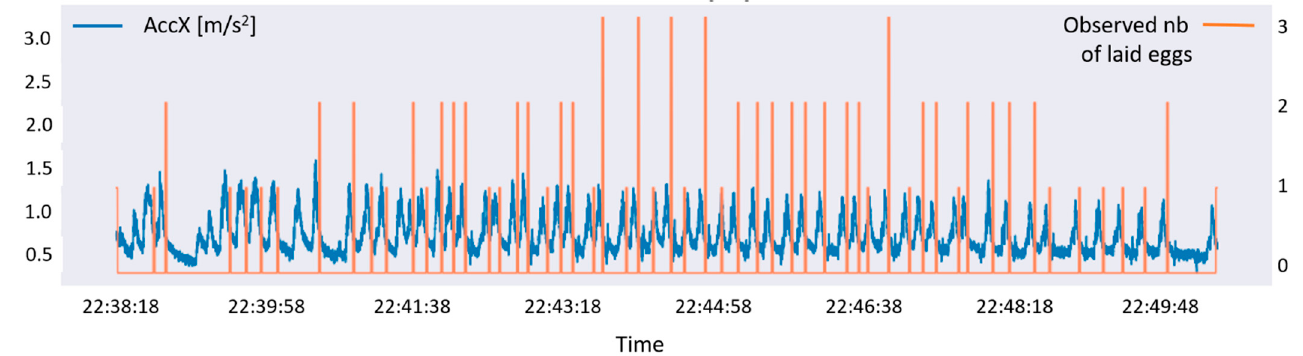
Figure 2. Visualization of the surge acceleration axis (back-to-front or X-axis, in blue) of one green turtle associated with the number of laid eggs counted in the field (in